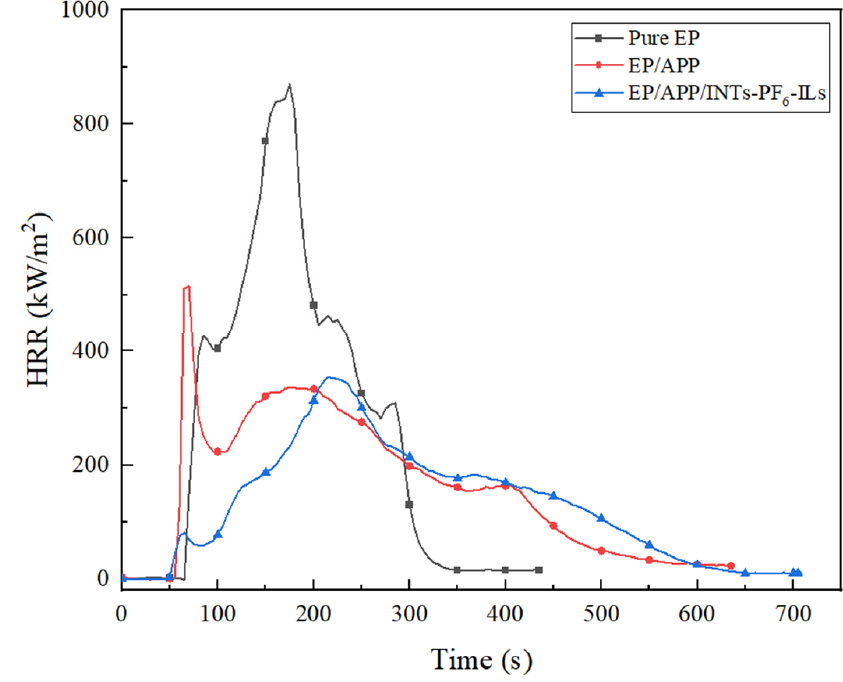
Figure 2. HRR curves of EP composites.